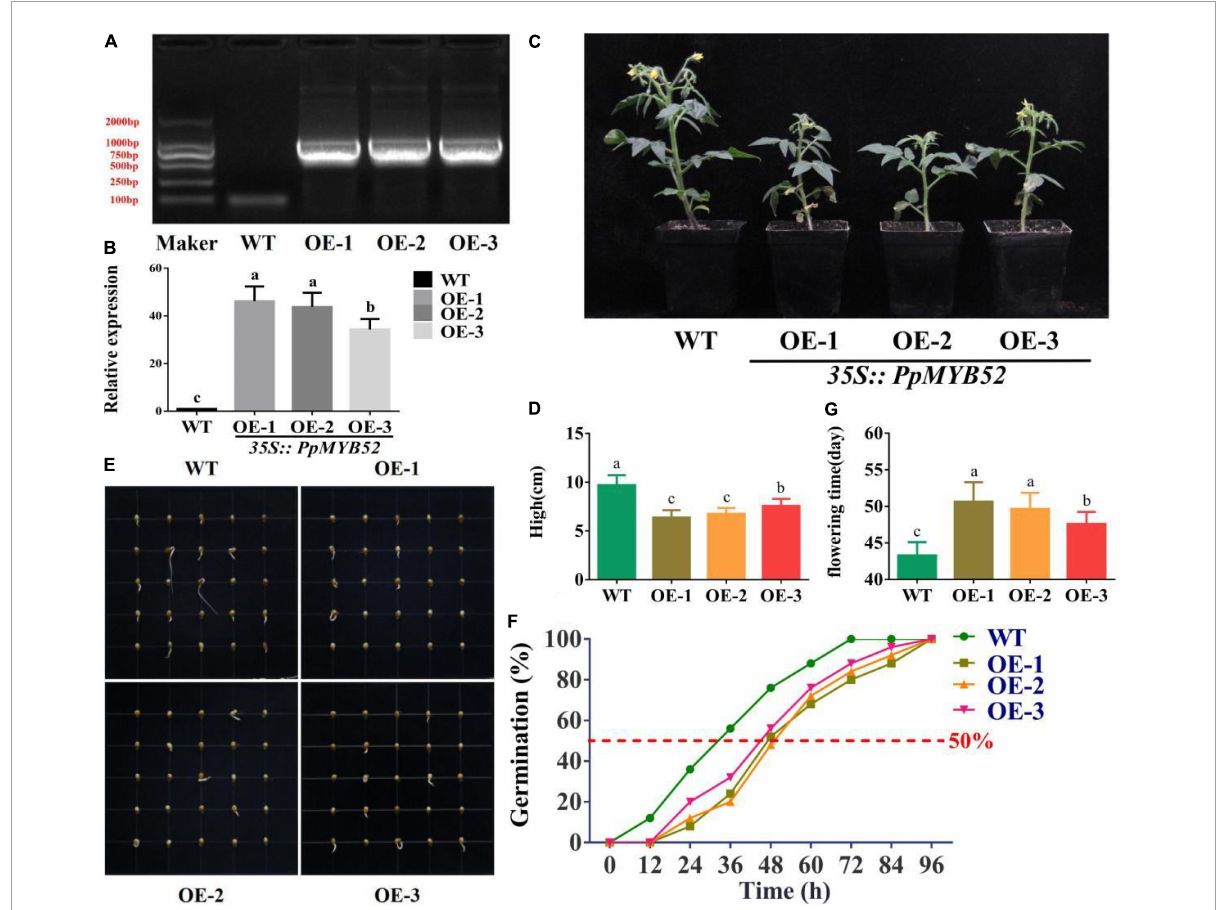
FIGURE4 Overexpression of PpMYB52 in tomato suppresses seed germination and reduces plant height. (A) Reverse transcription polymerase chain reaction (RT-PCR) analysis results of PpMYB52 -overexpressing transgenic lines. (B) qRT-PCR analysis results of PpMYB52 transgenic tomato lines under normal conditions. SlActin was used as a reference gene. (C) Phenotypes of PpMYB52- overexpressing transgenic tomato and Micro Tom wild-type tomato. (D) Plant height of PpMYB52- overexpressing transgenic tomato and Micro Tom wild-type tomato. Each group comprised 20 plants, and the results are the averages of 20 plants. (E,F) Determination of the germination of seeds of Micro Tom wild-type tomato and PpMYB52 -overexpressing transgenic tomato in MS media. (G) Flowering time of PpMYB52 -overexpressing transgenic tomato and Micro Tom wild-type tomato. The time is the number of days between planting and the first flower opening. Each group comprised 20 plants, and the results are the averages of 20 plants. The values represent the means ± SD of three replicates, and the different letters above the bars represent significant differences; P <